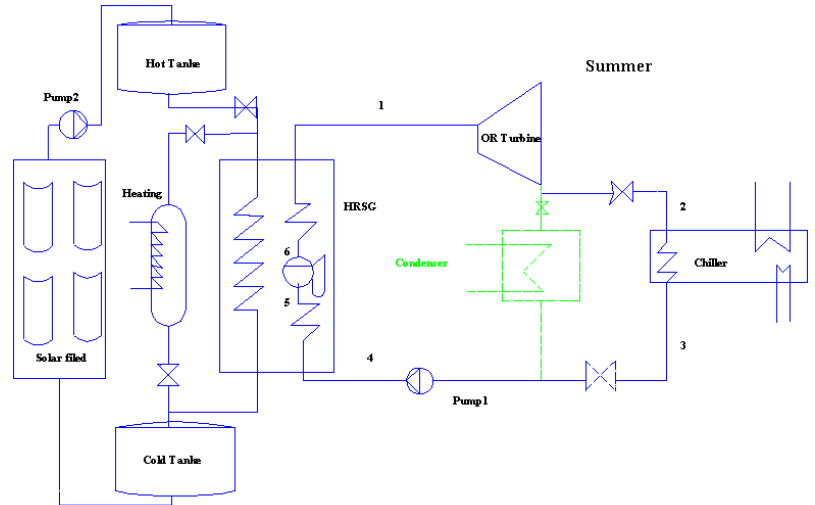
Figure 2. Schematic of the organic cycle combined with solar field in hot seasons in the absence of condenser